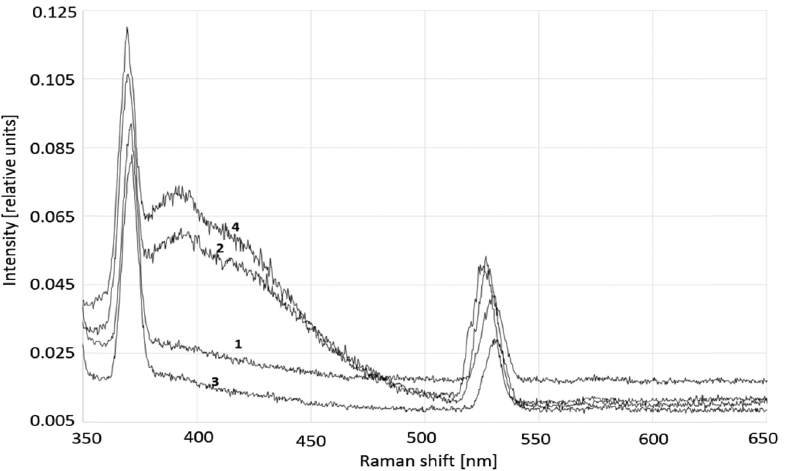
Figure 1: Raman spectra of deionized ammonia - free ( 1 ) and ammonia - containing water ( 3 ) prior to the GP treatment and these samples after such treatment, ( 2 ) and ( 4 ) ,